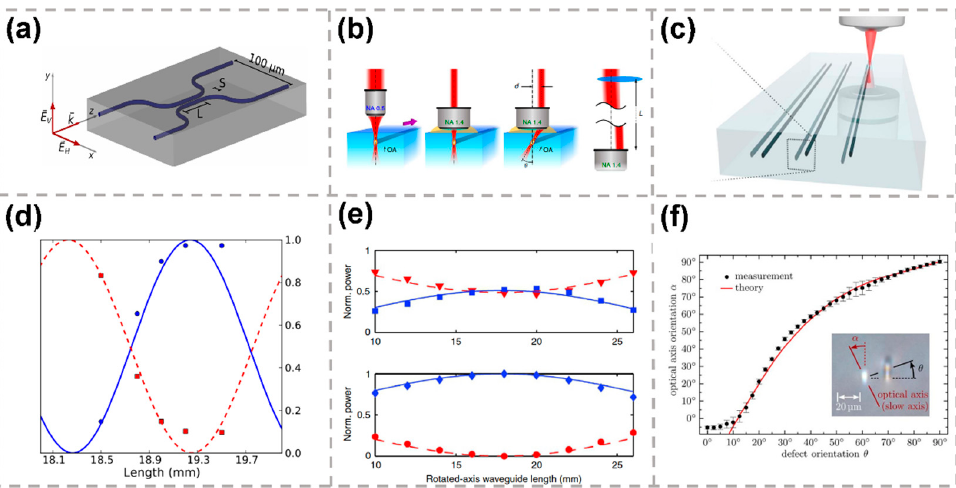
Figure 9. ( a ) Schematic of the integrated polarization directional coupler (PDC) [110]. ( b ) Femtosecond laser writing of tilted integrated waveplates [115]. ( c ) Sketch of the writing setting, with which the waveplates are fabricated [109]. ( d ) Measured coupling ratio, r, as a function of coupling length for vertical polarized (blue circle) and horizontal polarized (red square) modes together with calculated fits (solid and dashed lines) [110]. ( e ) For horizontally polarized input light, the measured normalized power transferred into the horizontal/vertical polarization states and diagonal/antidiagonal polarization states is reported [115]. ( f ) Experimental data and best fit model of the reorientation of the optical axis as a function of the azimuthal position of the defect [109]. Reproduced from [110] with permission of the Optica Publishing Group, 2022. Reproduced from [109,115] with permission of the Springer Nature, 2022.